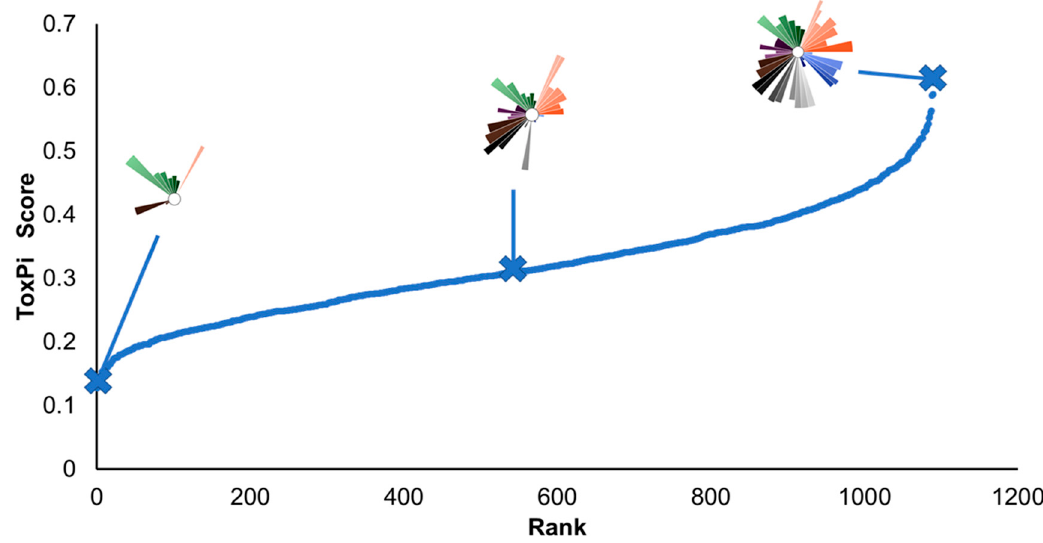
Figure 2. The overall distribution of Toxicological Prioritization Index (ToxPi) scores across all 1090 census tracts. Each dot in this rank plot is one tract. The profiles of the top (i.e., highest ToxPi score on vertical axis), median, and lowest tracts are shown along the distribution. ToxPi indicator colors are shown in Figure 1 (starting from the 3 o’clock position, going counterclockwise: orange = social vulnerability; green = baseline health; purple = environmental exposures and risks; grey = environmental sources; blue = flooding).